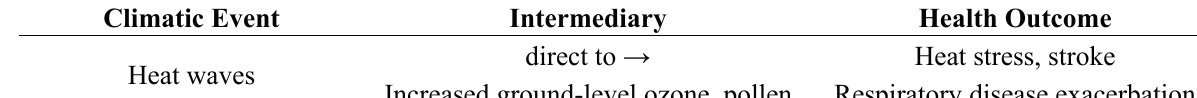
Table 2. The Health Effects of Climate